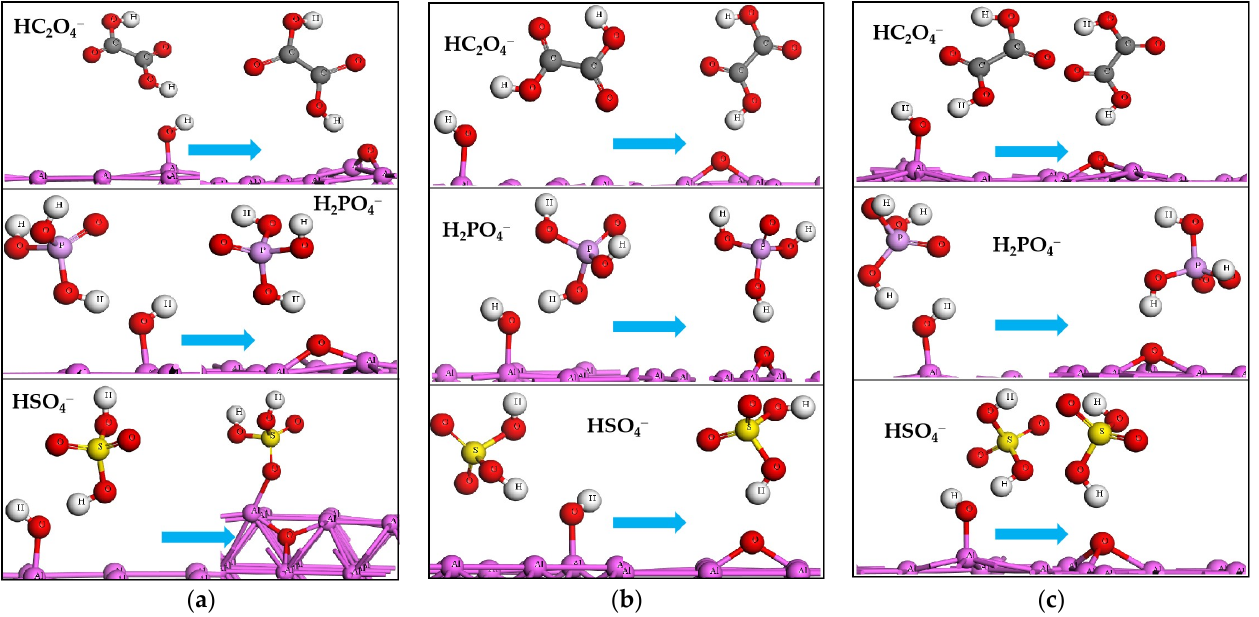
Figure 2. The acid radicals stripping off the two H of H 2 O by two steps on the anodic aluminum slabs: ( a ) the (100) +1 , ( b ) the (110) +1 , ( c ) the (111) +1 surfaces.